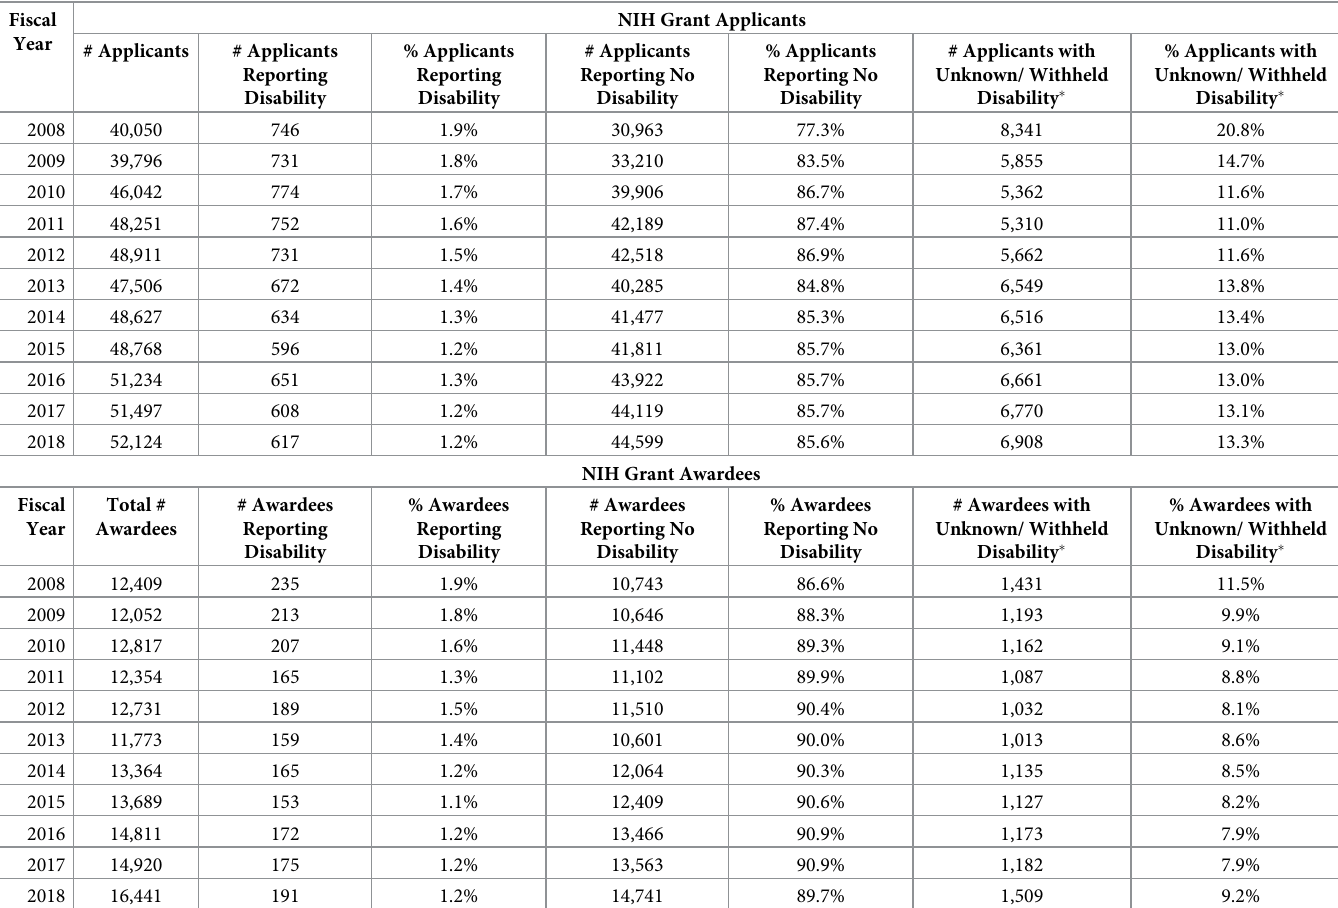
Table 1. Number and percentage of National Institute of Health Grant Applications and Awardees by Principal Investigator Disability Status: 2008 to